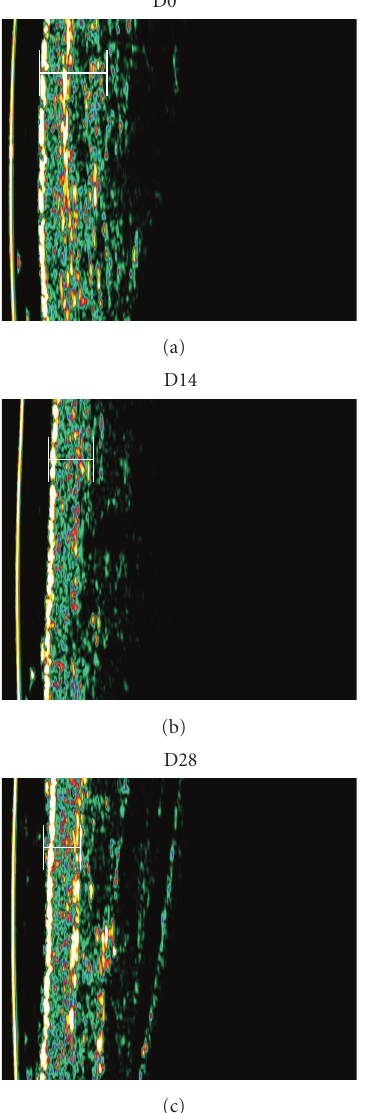
Figure 3: Illustrative examples of sonography images showing the apparent reduction in the full thickness area from D0 to D28 as a consequence of the treatment